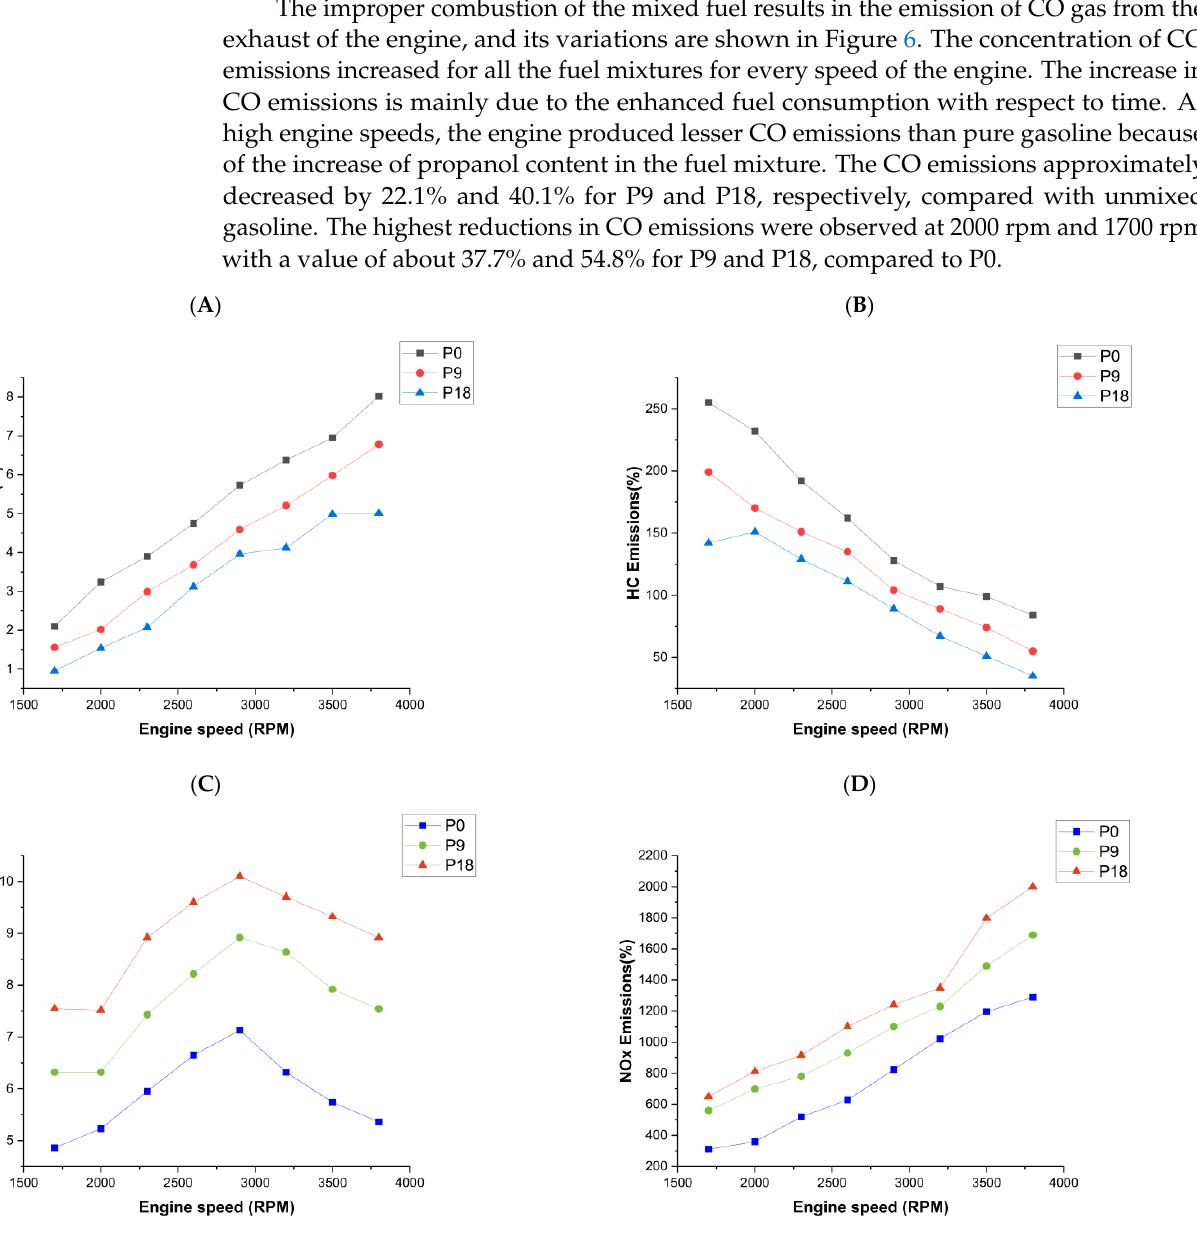
Figure 6. ( A – D ) Variations in CO, HC, CO 2 , and NOx emissions for the three fuels. Adding propanol in the gasoline makes a mixture with a reduced hydrocarbon frac- tion that results in lesser HC emissions [11]. On the other hand, CO 2 is the major compo- nent in greenhouse gases released due to the burning of fuels in the engines. According to the air-fuel stoichiometric ratio, combustion should only have two products, i.e., H 2 O and CO 2 . However, in actuality, incomplete combustion results in various other unwanted particles and emissions in the air during the intake stroke. Figure 6 shows the variation of the CO 2 concentrations, with respect to the varying engine speeds (RPM), and clearly shows the increase in CO 2 concentrations with the increase in engine speeds. This trend continues until 2900 rpm, where the CO 2 emissions are the highest, and then start decreas- ing after 2900 rpm. The blended fuels showed 30.0% and 52.2% elevated CO 2 emissions for P9 and P18, respectively, compared to P0. As CO 2 is directly related to almost all the engine parameters such as brake torque, fuel consumption, and thermal efficiency, an in- creased amount of blended fuel will be required to produce the same brake power at con- stant throttle. Moreover, the ratio of oxygen in mixed fuels is mainly responsible for enhanced com- bustion and increased CO 2 emissions [31]. The air intake in spark-ignition engines also contain nitrogen gas and other gases that flow inside the combustion chamber. The key causes behind the NO x emissions through the exhausts of SI engines are enhanced tem- perature, ratio of oxygen, and the time of air residence in the cylinder [32]. Graphical anal- yses of the NO x with respect to engine speeds are shown in Figure 6. The graph clearly shows that NO x emissions increase with the engine speed due to the increase in tempera- ture of the engine. The increase in NO x emissions was approximately 47.8% and 71.8% for